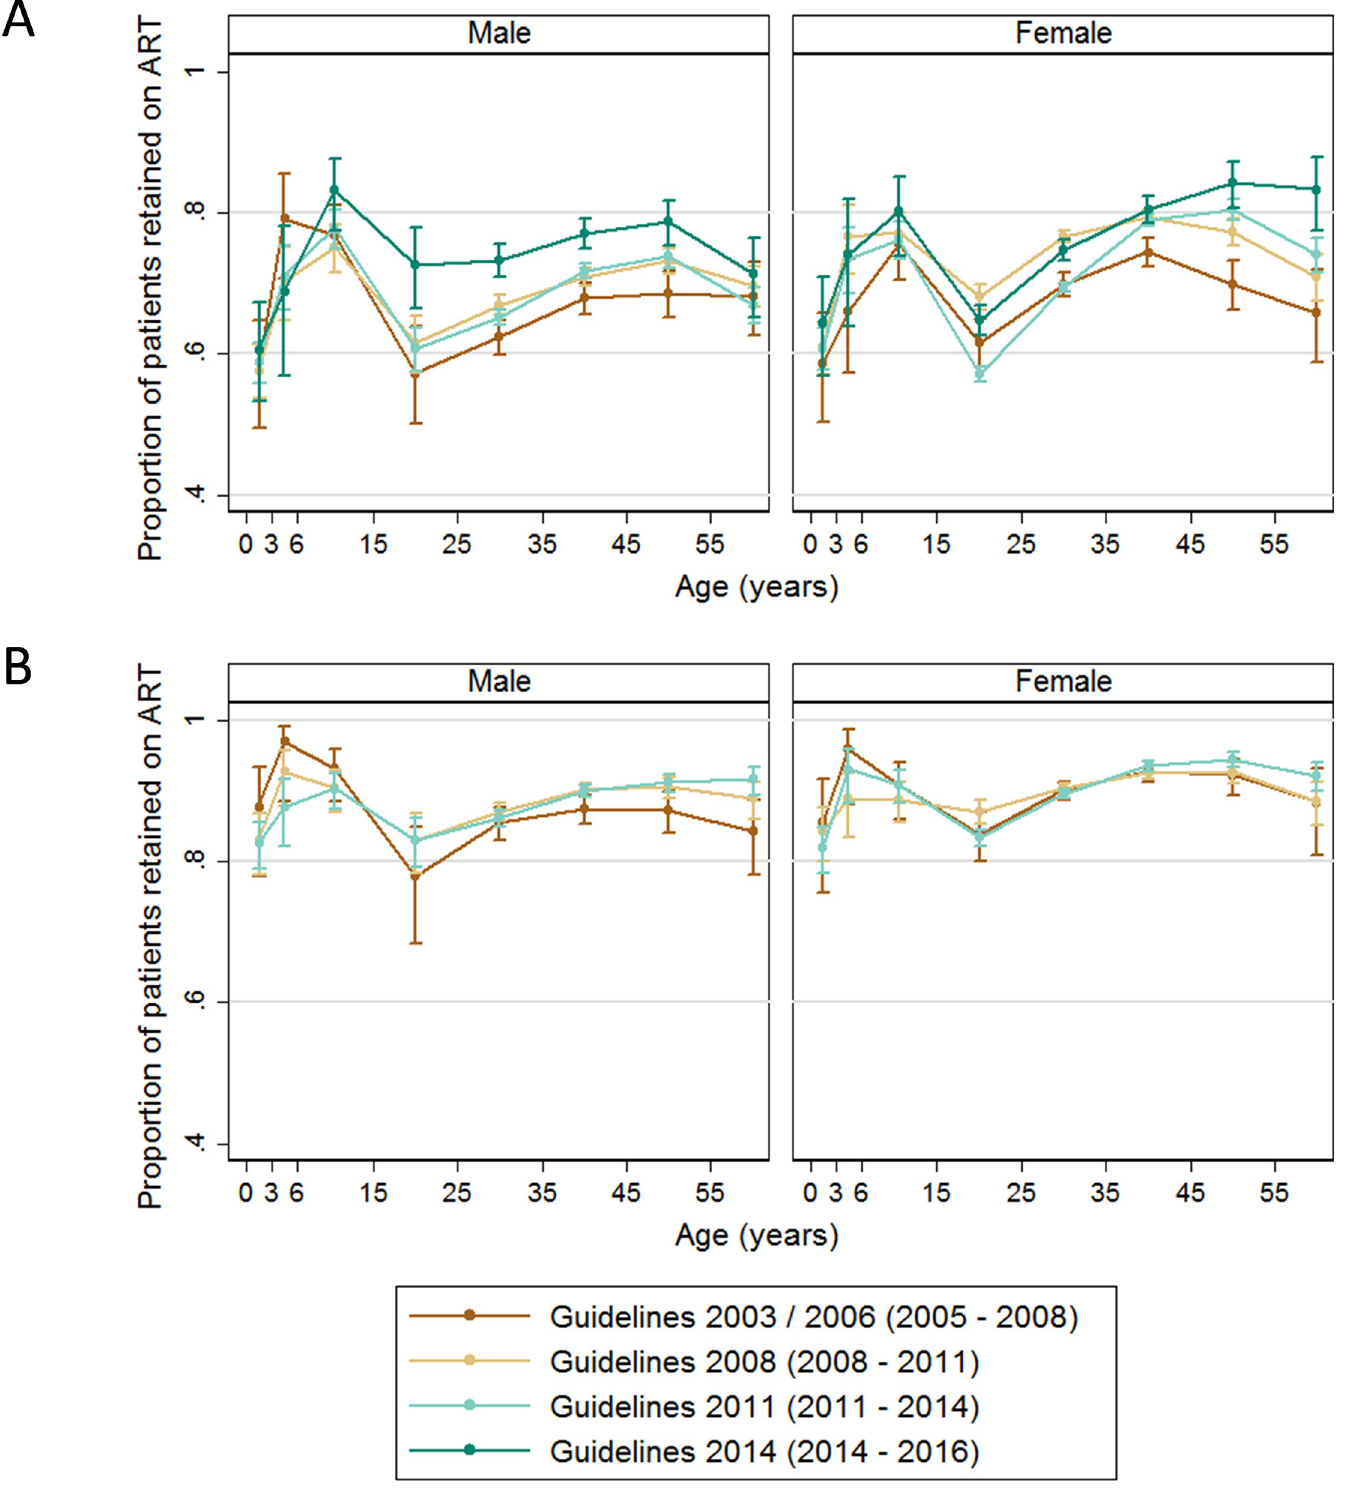
Fig 1. Crude retention at clinic according to gender and guideline periods. (A) at 1 year (B) at 2 years for those who were retained by the end of year 1 C) at 5 years for those who were retained at the end of year 2 note that the scale of the y axis does not start at 0.